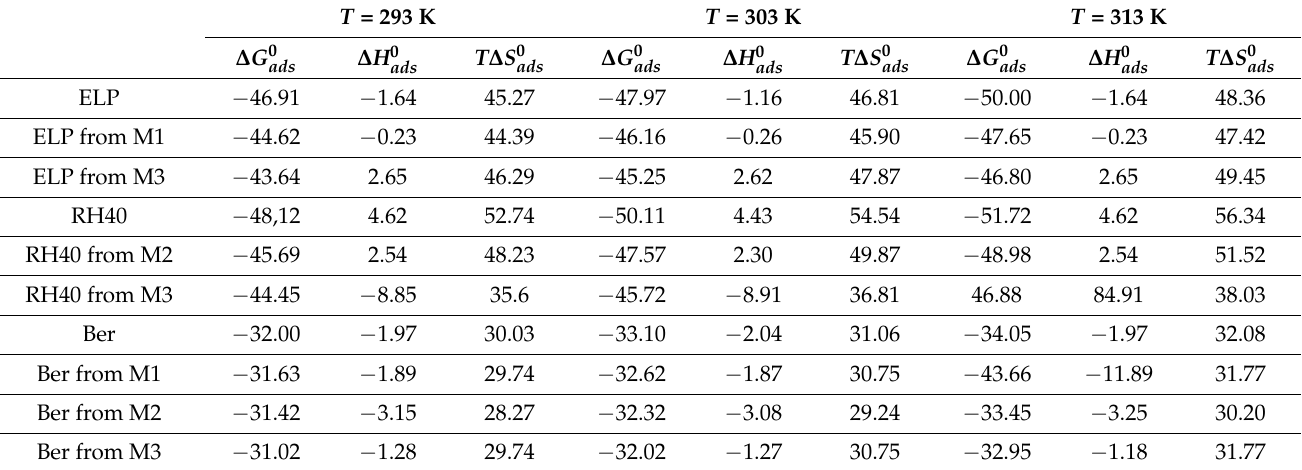
Table 4. Thermodynamic parameters of the adsorption process of ELP, RH40 and Ber